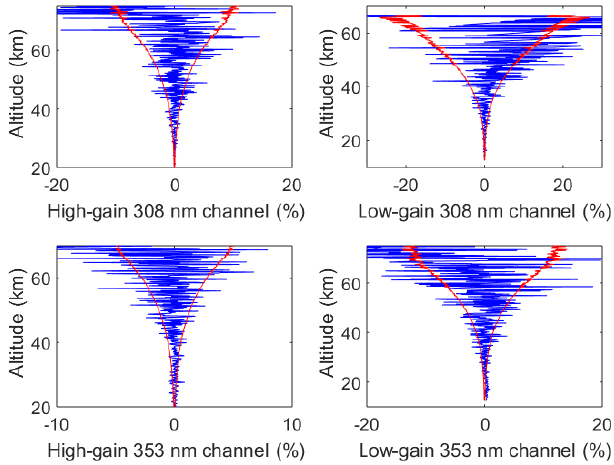
Figure 3. Averaging kernels for the ozone density for the measure- ments on 26 July 2017. The horizontal dashed line is a height below which the OEM retrieval is more than 80% due to the measure- ments. Above this horizontal cutoff as the SNR drops, the retrieval starts to fall back to the a priori profile. For clarity, the averaging kernels are only shown every 1500m in altitude. The red line shows the summation of rows in the averaging kernel matrix at each alti- tude. The summation is of order unity below 42.7km.